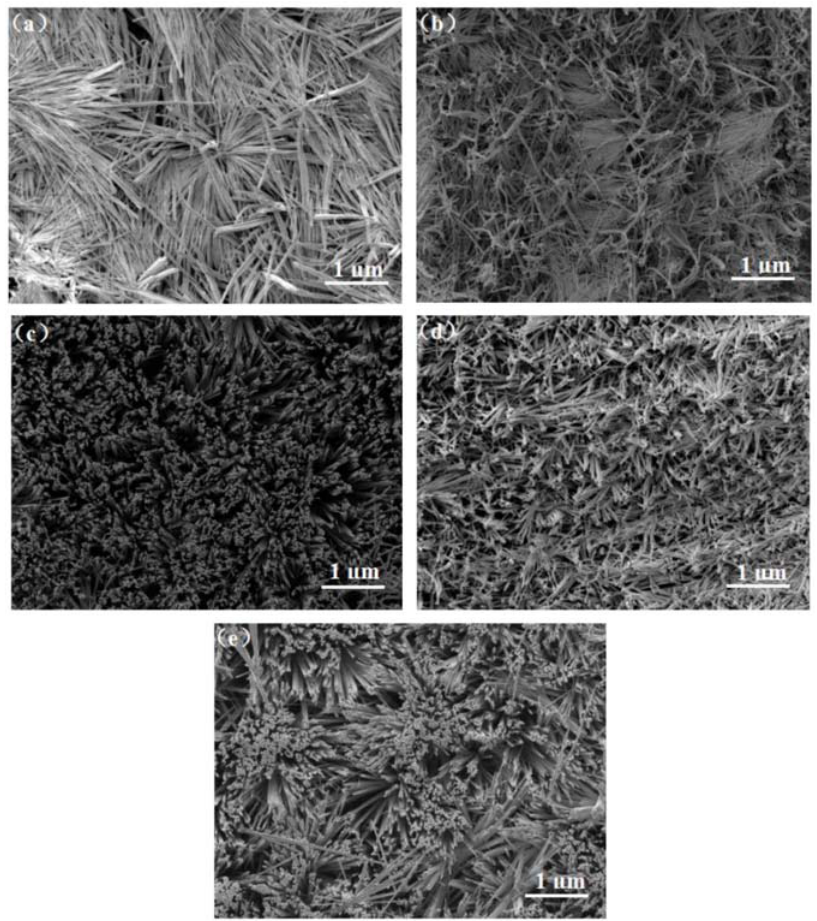
Figure 6. The scanning electron microscope (SEM) images of perovskite thin films with different ratios of DMSO ( a ) 0%; ( b ) 5%; ( c ) 10%; ( d ) 15%; ( e ) 20%.